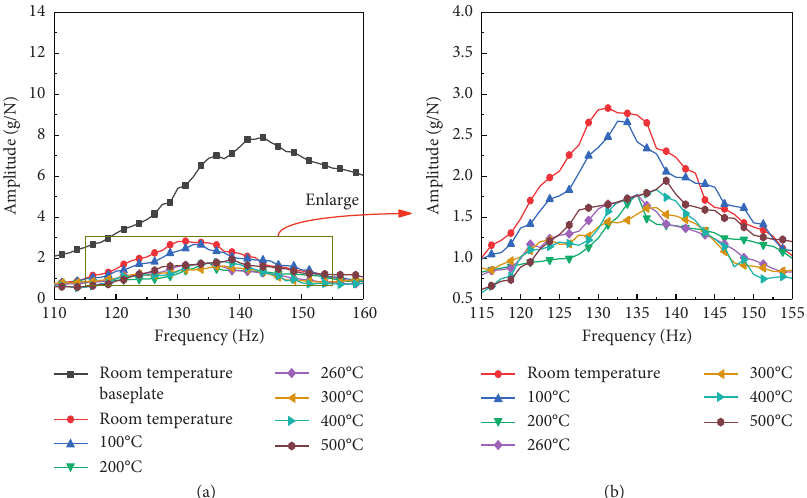
Figure 18: Frequency response curves of cantilever structure under different temperatures. (a) Second-order FRCs and (b) drawing of second-order